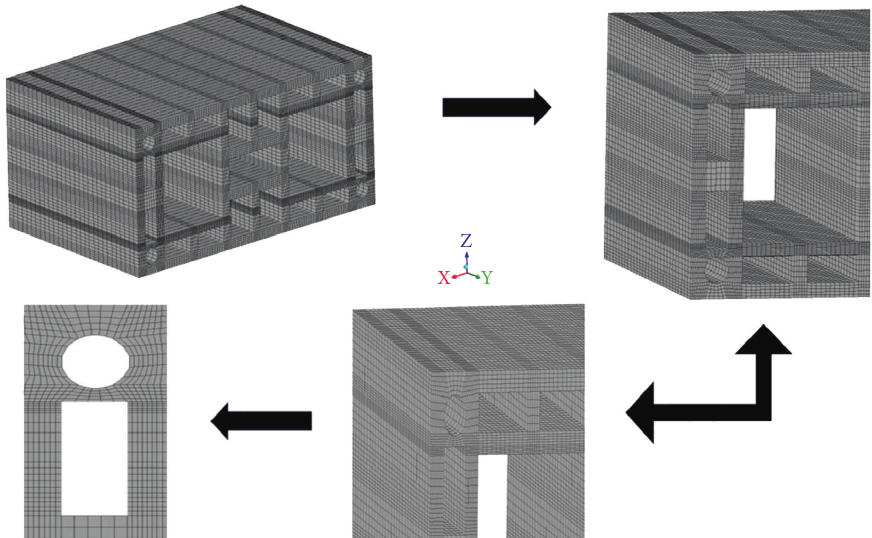
Figure 2: Computational representation of the industrial clay brick used in this